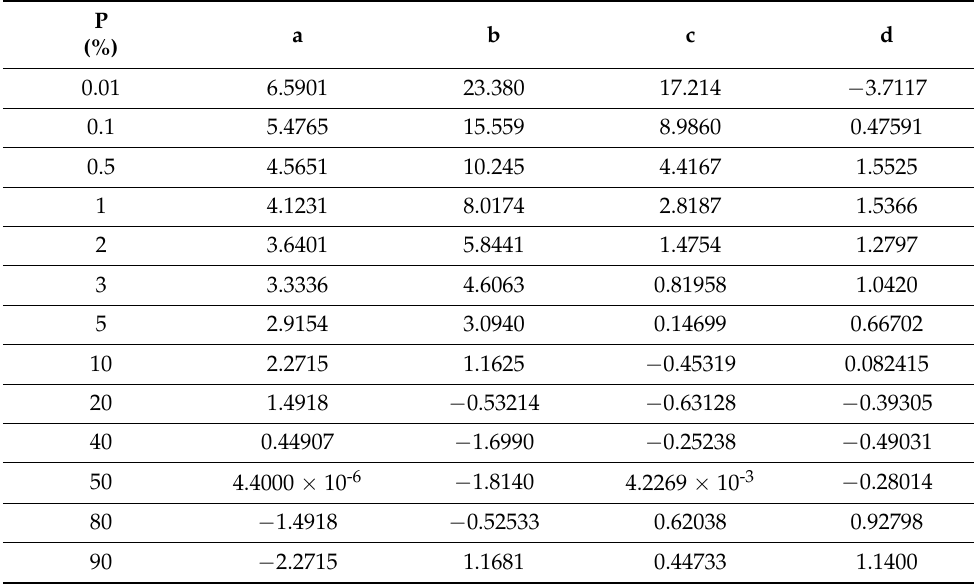
Table A3. The frequency factor for estimation with L-moments for Pearson